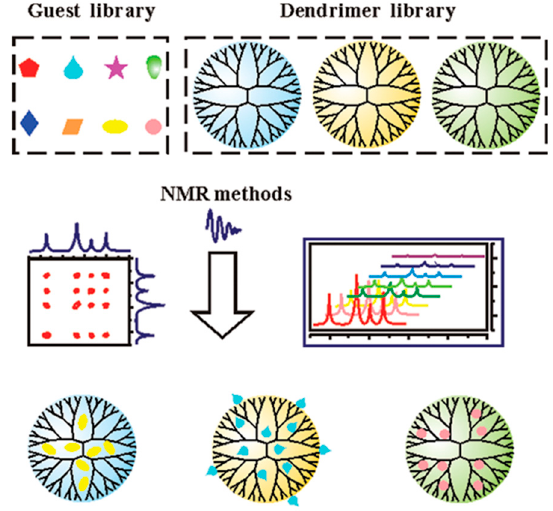
Figure 32. Systematic NMR characterization of dendrimer encapsulation properties as a function of a small molecule guest and dendrimer host library. Reprinted with permission from [97]. Copyright 2012 American Chemical Society.